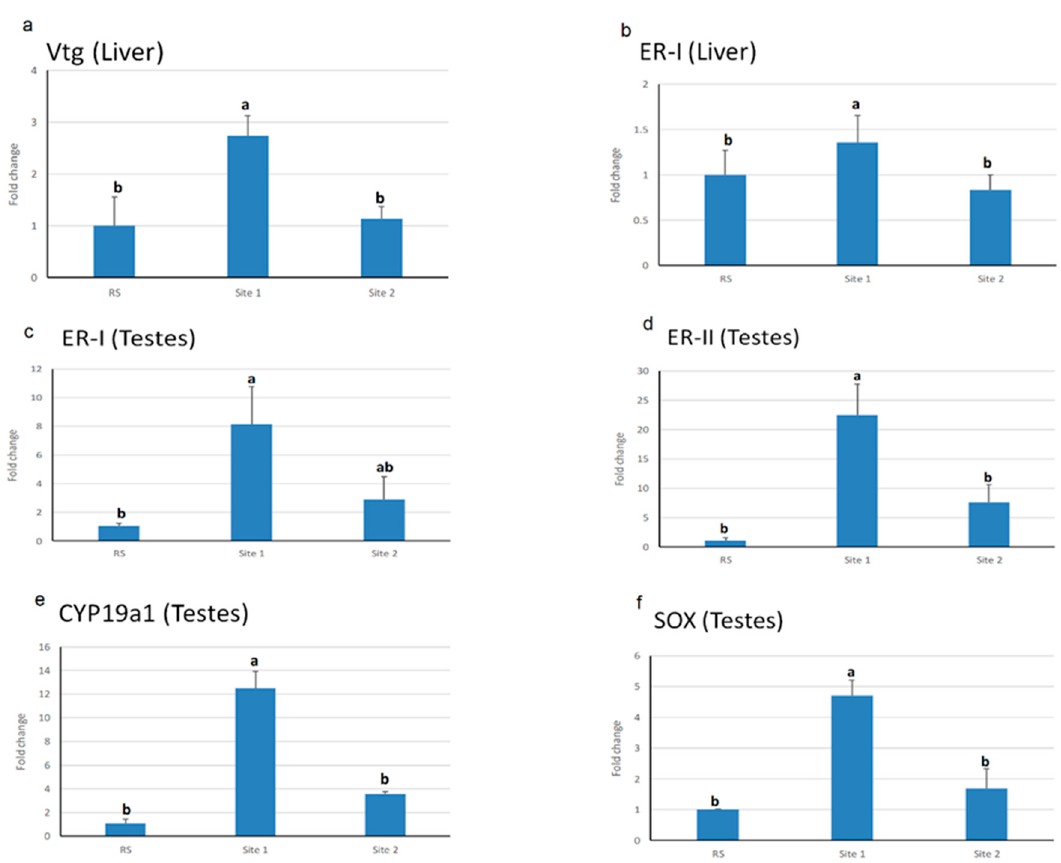
Figure 3. Vitellogenin ( vtg ) ( a ), estrogen receptor-type I ( er-I ) ( b ) mRNA levels in the liver; and er -I ( c ),